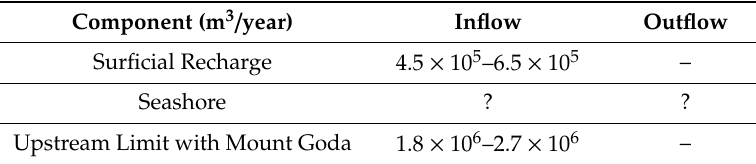
Table 1. Components of the aquifer water balance estimated by the CERD [23].